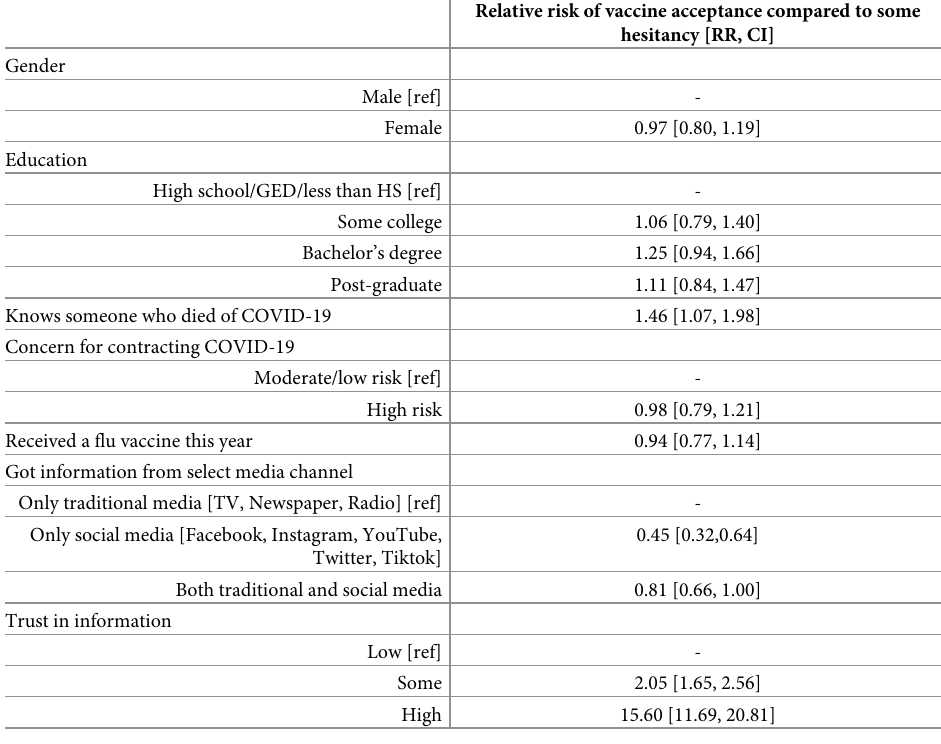
Table 4. Multivariable multinomial regression of likelihood of vaccine